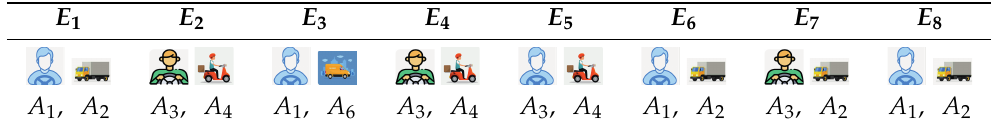
Table 2. CRT for our log file